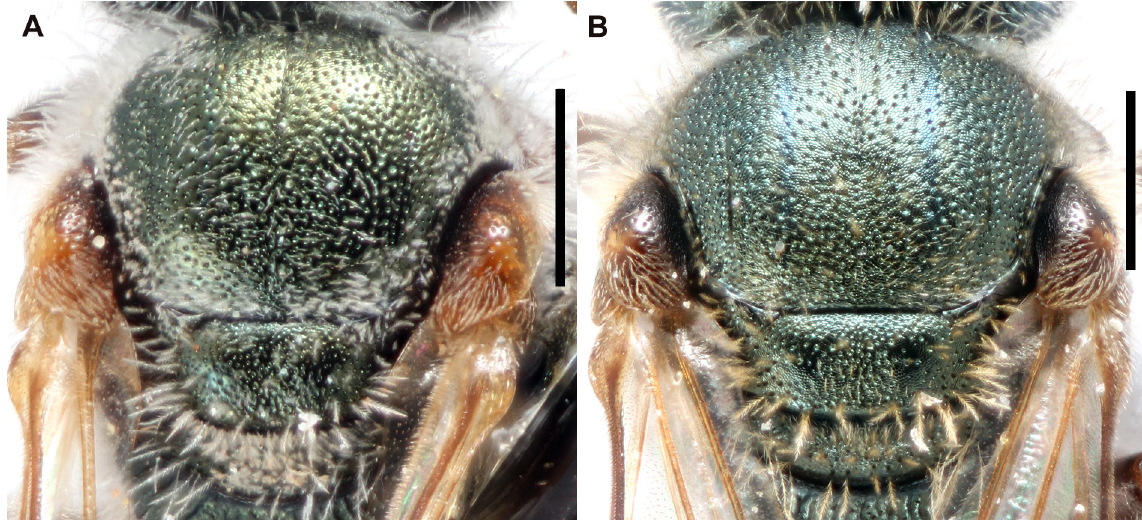
Fig. 83. Mesonotum. A . Lasioglossum gloriosum sp. nov., ♀, with dense tomentum on metanotum and margins of mesoscutum. B . L. tegulare (Robertson, 1890), ♀, with sparse tomentum. Scale bars = 0.5 mm.